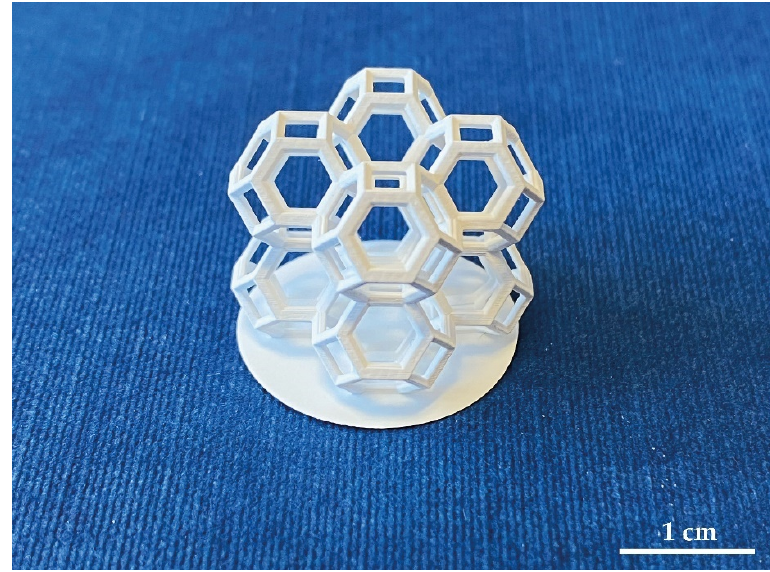
J. Compos. Sci. 2021 , 5 , 244 Figure 7. Lattice structure in ATZ printed by the DLP technique. Figure 7. Lattice structure in ATZ printed by the DLP technique.